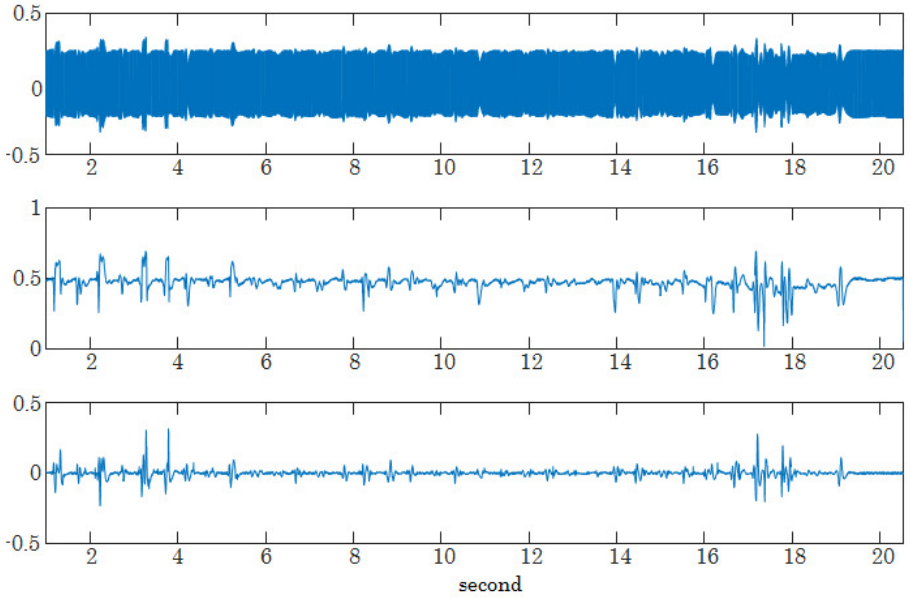
Figure 5. Anexampleofsignalsreceivedfromthesensordevicewhenpizzawaseaten. Top : Thebandpass filtered signal. Middle : Demodulated signal. Bottom : Audio signal obtained by the low-pass